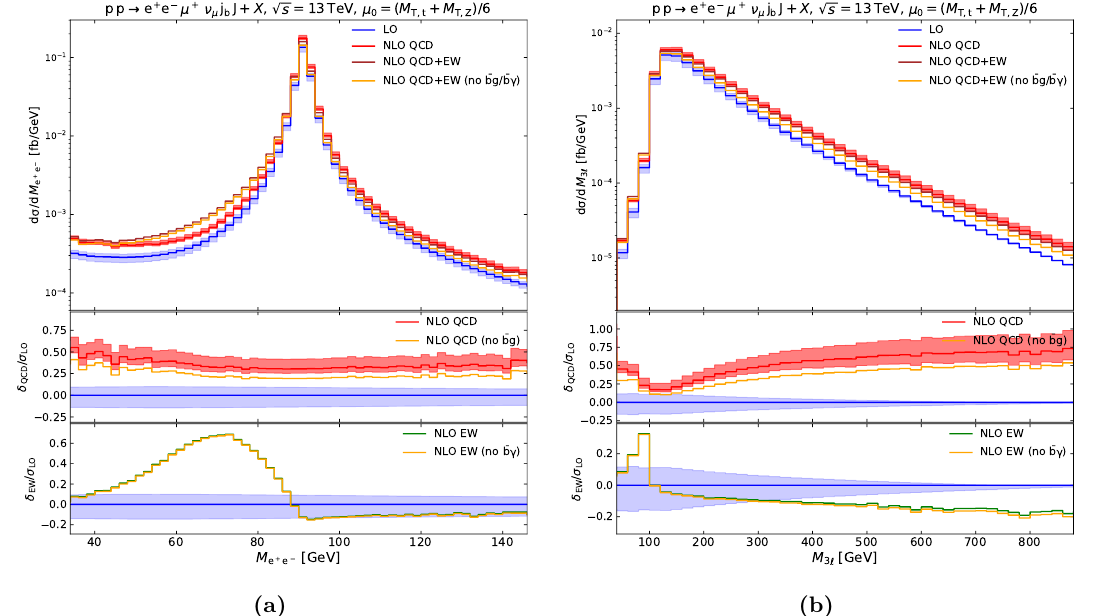
Figure 7. Invariant-mass distributions of the same-flavour lepton pair and of all three charged leptons.